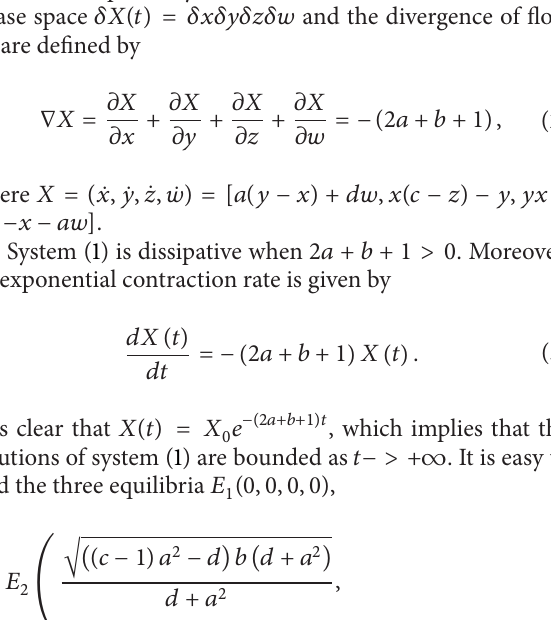
where 𝑋 = ( ̇𝑥, ̇𝑦, ̇𝑧, ̇𝑤) = [𝑎(𝑦 − 𝑥) + 𝑑𝑤, 𝑥(𝑐 − 𝑧) − 𝑦, 𝑦𝑥 − 𝑏𝑧, −𝑥 − 𝑎𝑤]